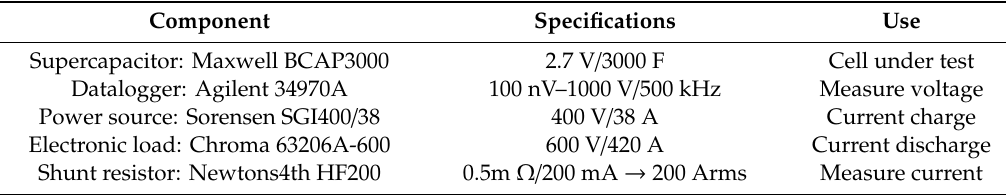
Figure 9. Experimental setup. Table 2. Equipment and Components used in the Experimental Setup.